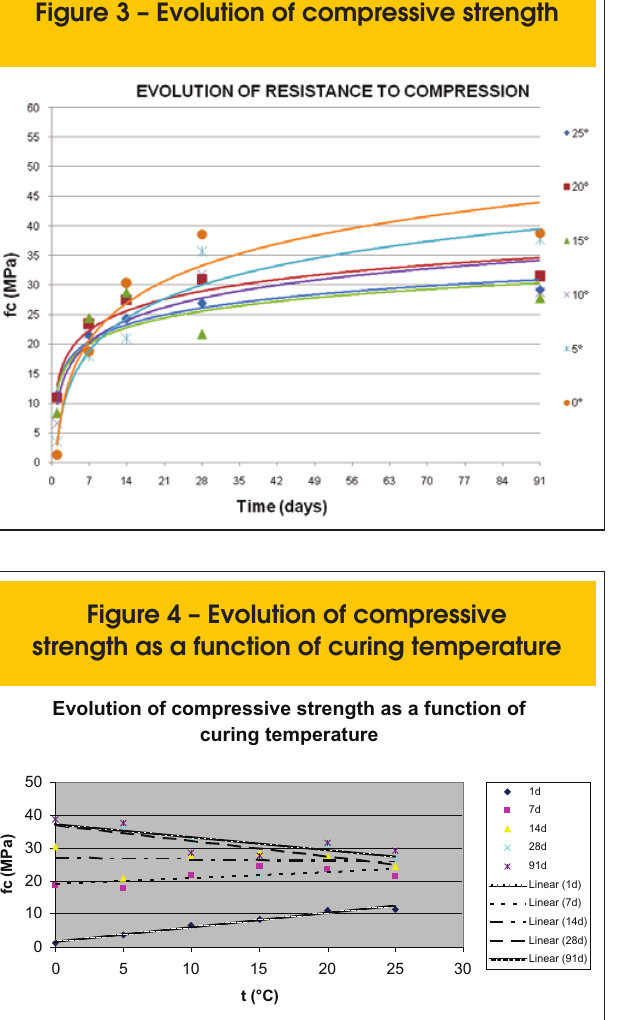
Figure 3 – Evolution of compressive strength